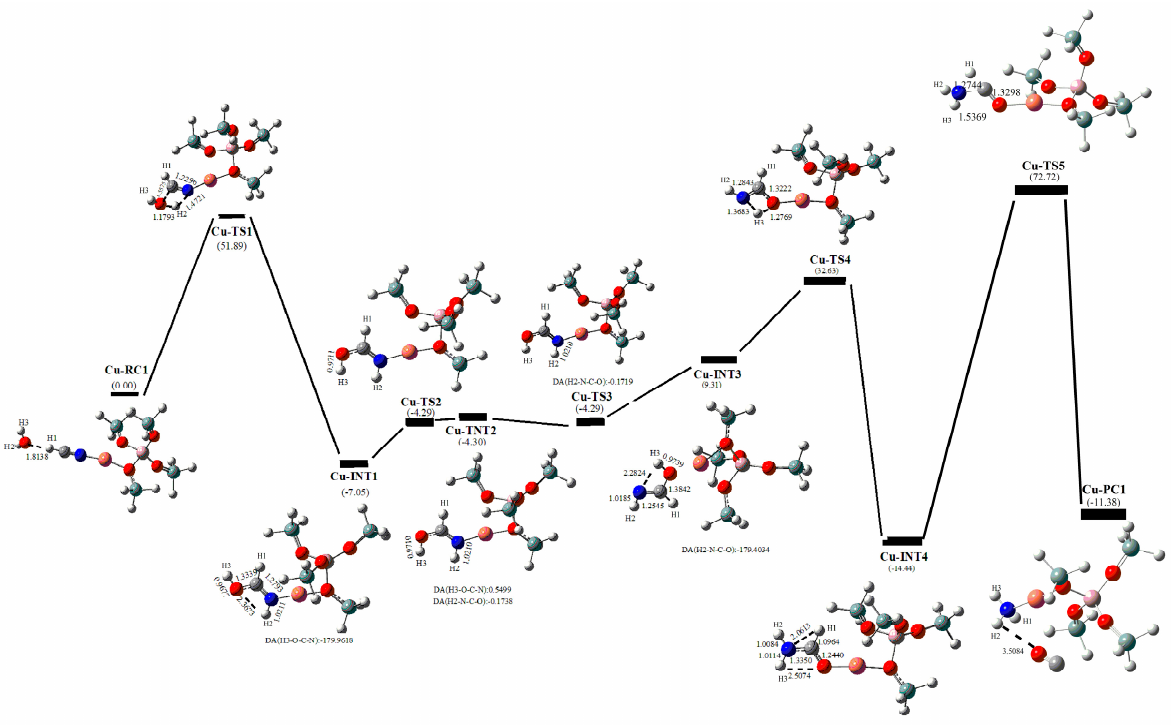
Figure 4. B3LYP/6-31++G (d,p)-optimized structures (in Å) of the stationary points of hydrolysis of HCN with Cu-ZSM5 in the gas phase of path A. The values correspond to the relative free energy ( ∆ G) in kcal/mol with respect to the separate reactants.